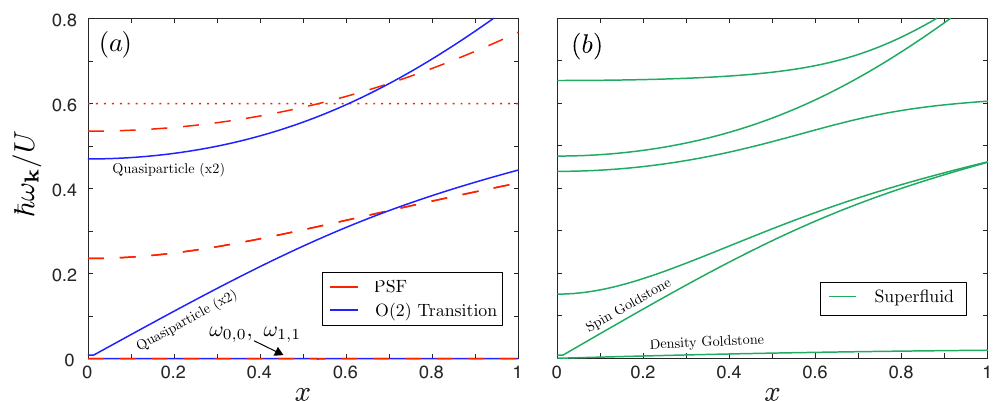
Figure 6: Excitation spectra (a) along the PSF-to-SF second-order transition with ≈ 1.47 and ( µ/ U ) = − 0.35 and (b) in the SF phase for µ/ U ≈ − 0.35 and n c 0, d / U = − 0.7 in d = 2. In panel (a), the hopping energies are 2 d J / U = 0.08 U 12 ≈ 0.131 (blue lines). In the superfluid phase, we consider (red lines) and 2 d ( J / U ) c 2 d J / U = 0.14. The parentheses refer to the degeneracy of the hybridized quasipar- ticle